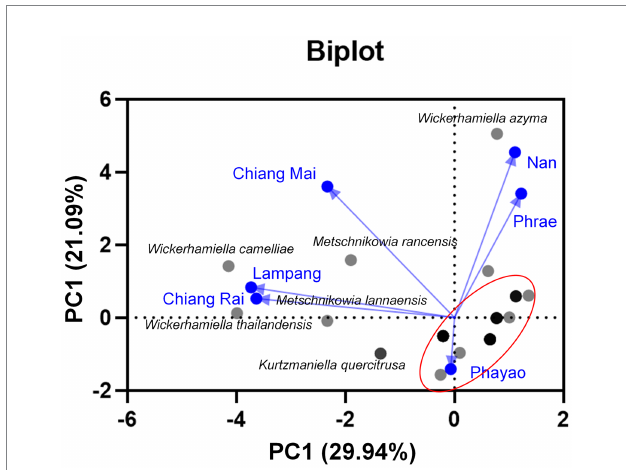
FIGURE 9 Principal component analyses of tannin-tolerant yeast species based on the relative abundance of yeast species in tea flower samples, and